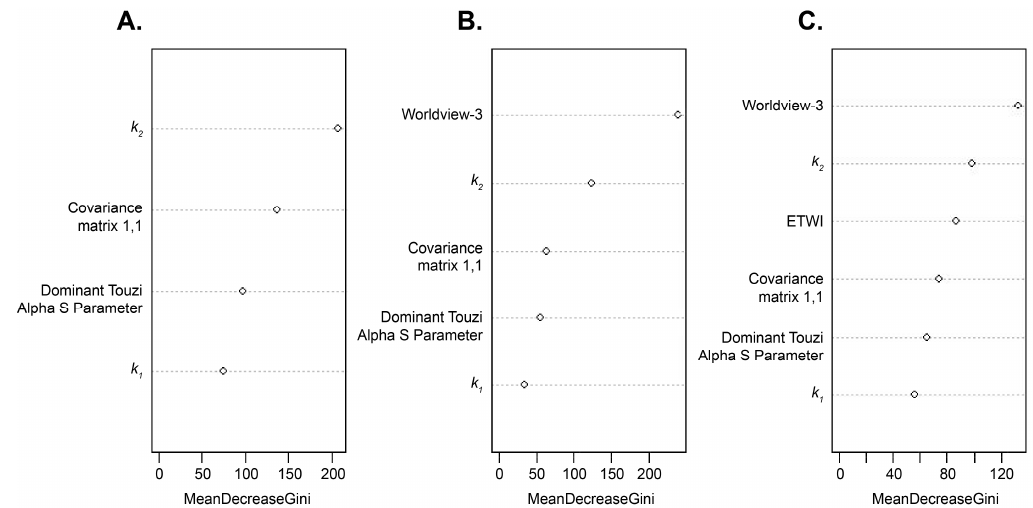
Figure 10. The mean decrease in node impurity which is indicative of variable relevance within the random forest models, ( A ) Radarsat-2 (9 April), ( B ) Radarsat-2 and Worldview-3 and ( C ) Radarsat-2, Worldview-3 and enhanced topographic wetness index (ETWI). The elements, k 1 and k 2 are the absorption difference parallel and diagonal in relation to the coordinate system.